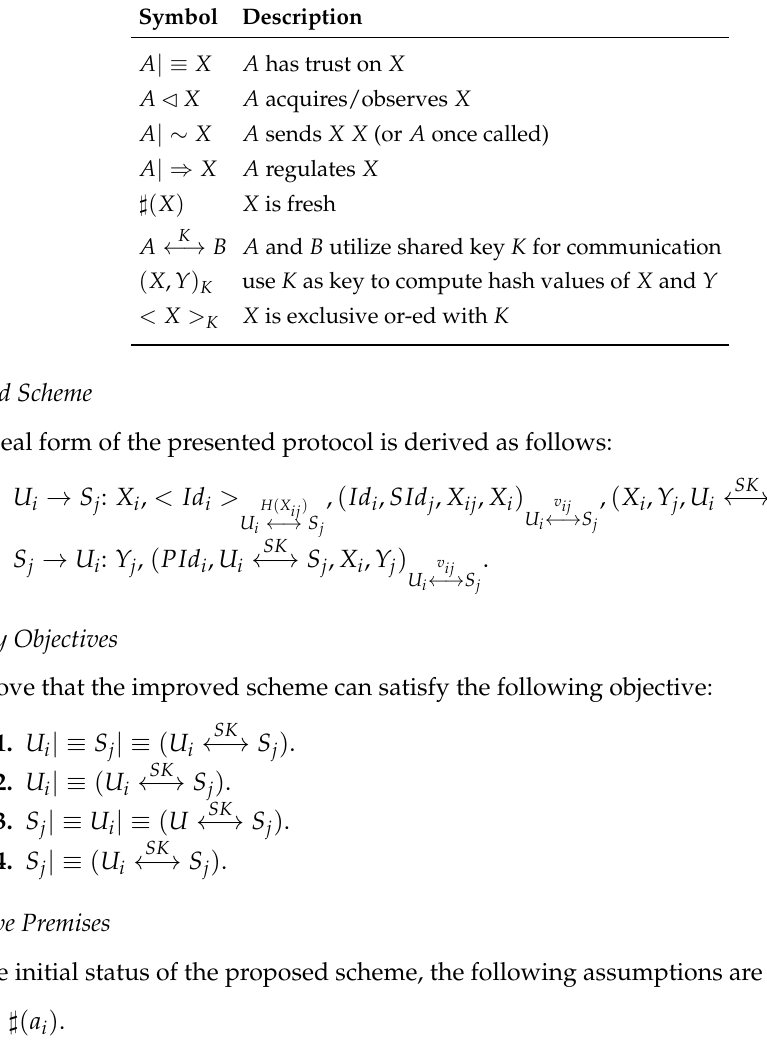
Table 2. Burrows–Abadi–Needham logic (BAN-Logic)